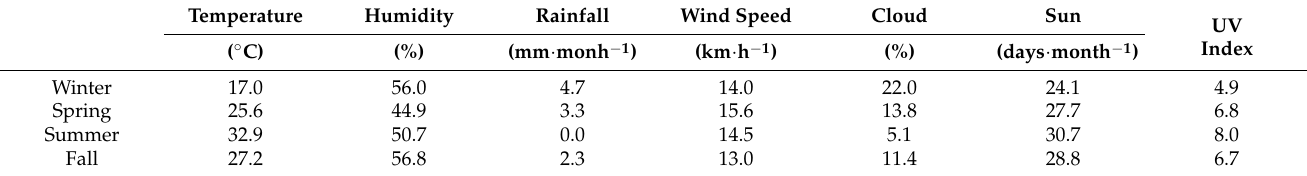
Table 4. Weather data of El-Khatatba, Menoufia, Egypt as the average of the 2018, 2019, and 2020 seasons.